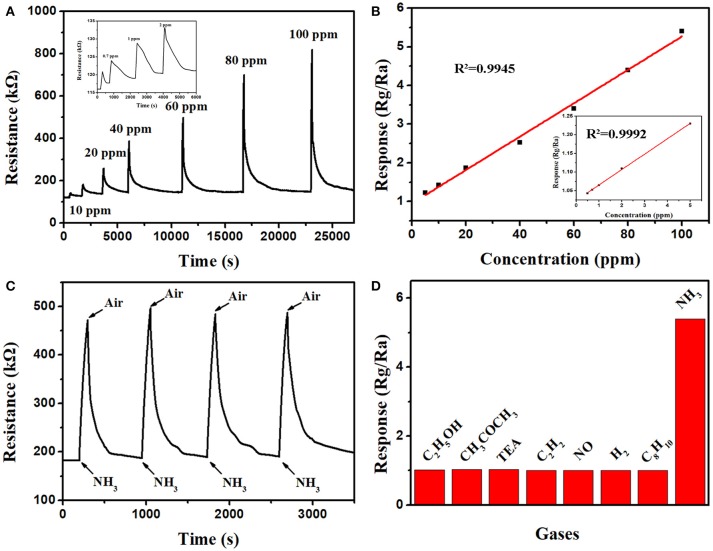
The response-recovery curves (A) and the linear relationship (B) of the PT3 nancomposites sensor to different concentrations of NH3; the reproducibility of the PT3 nancomposites sensor to 50 ppm NH3
(C); the selectivity of the PT3 nanocomposites sensor to 100 ppm of eight gases (D).